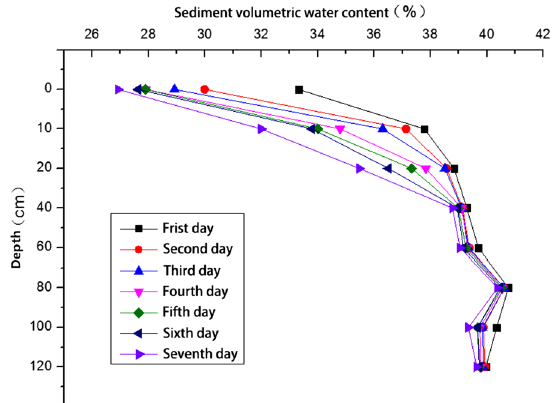
Fig. 7. The equation “ y = 5.2291 + 0.03751 x ” was